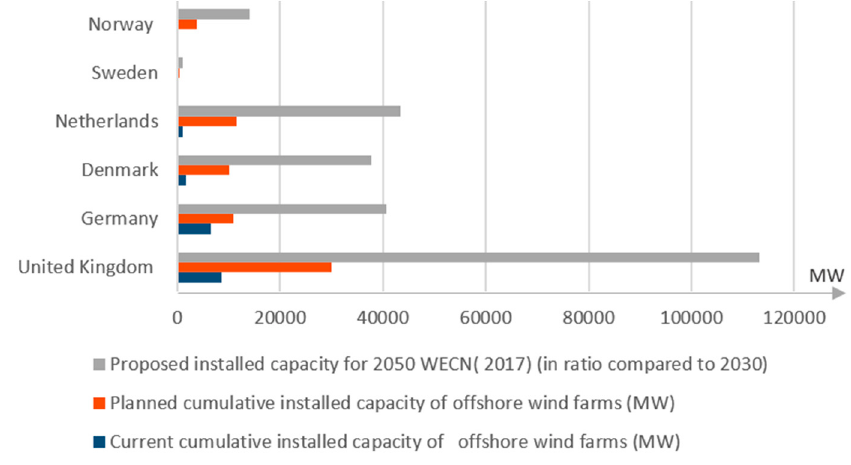
Figure 6. Current and planned (2030) cumulative capacity for offshore wind farms.